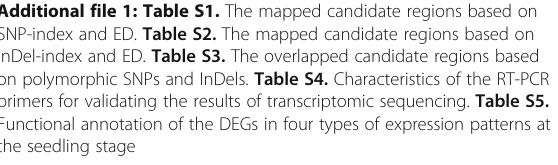
Additional file 1: Table S1. The mapped candidate regions based on SNP-index and ED. Table S2. The mapped candidate regions based on InDel-index and ED. Table S3. The overlapped candidate regions based on polymorphic SNPs and InDels. Table S4. Characteristics of the RT-PCR primers for validating the results of transcriptomic sequencing. Table S5. Functional annotation of the DEGs in four types of expression patterns at the seedling